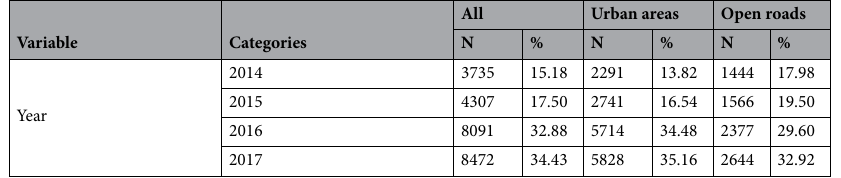
Table 1. Distribution of the study variables in the sample of cyclists, stratified by cycling area.